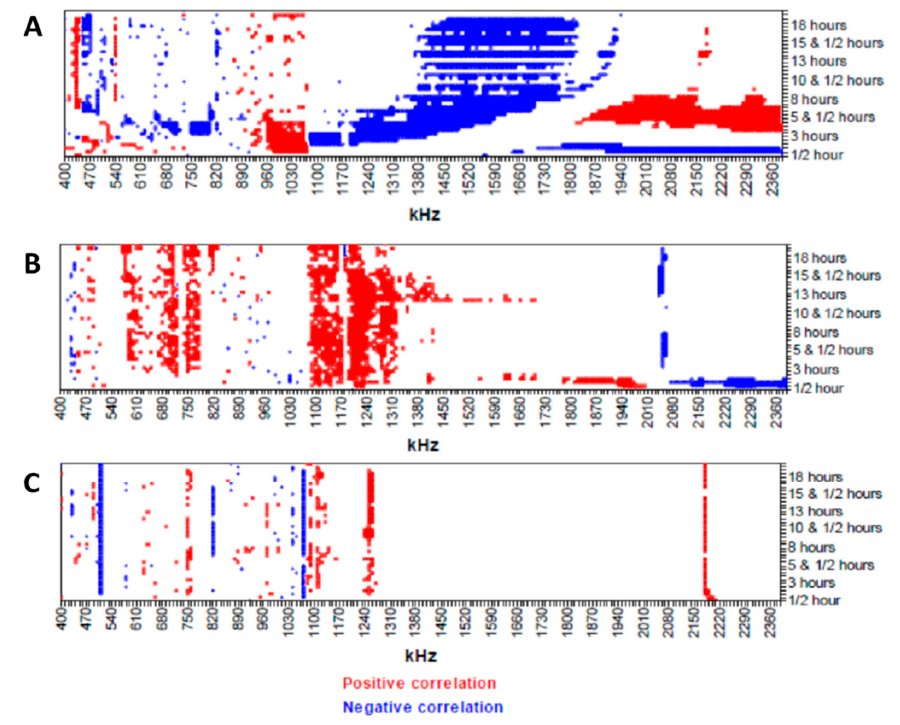
Figure 14. Toxin map of endothelial cells (ECV304) response to ( A ) dimethyl sulphoxide, ( B ) saponin, and ( C ) cadmium chloride treatment during 24 h at the frequency range 400–2400 kHz. Reprinted from Gasser et al. [99] with permission from Elsevier.